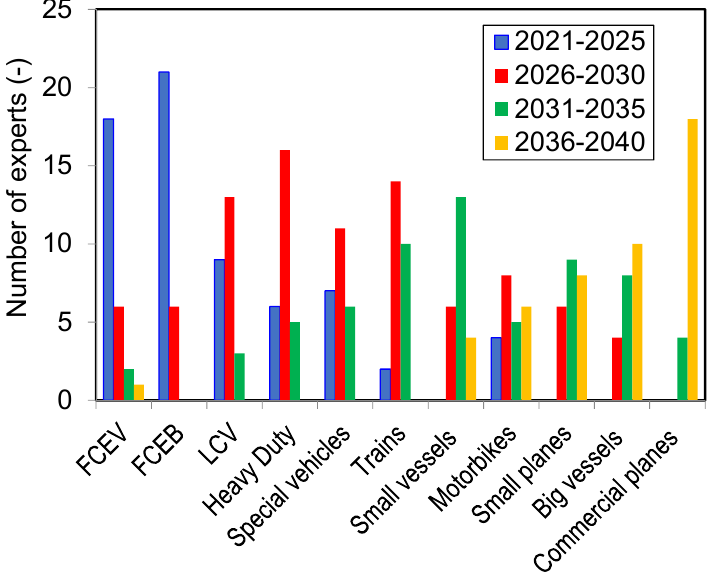
Figure 3. Time perspective for the implementation of hydrogen technologies in mobility [11].